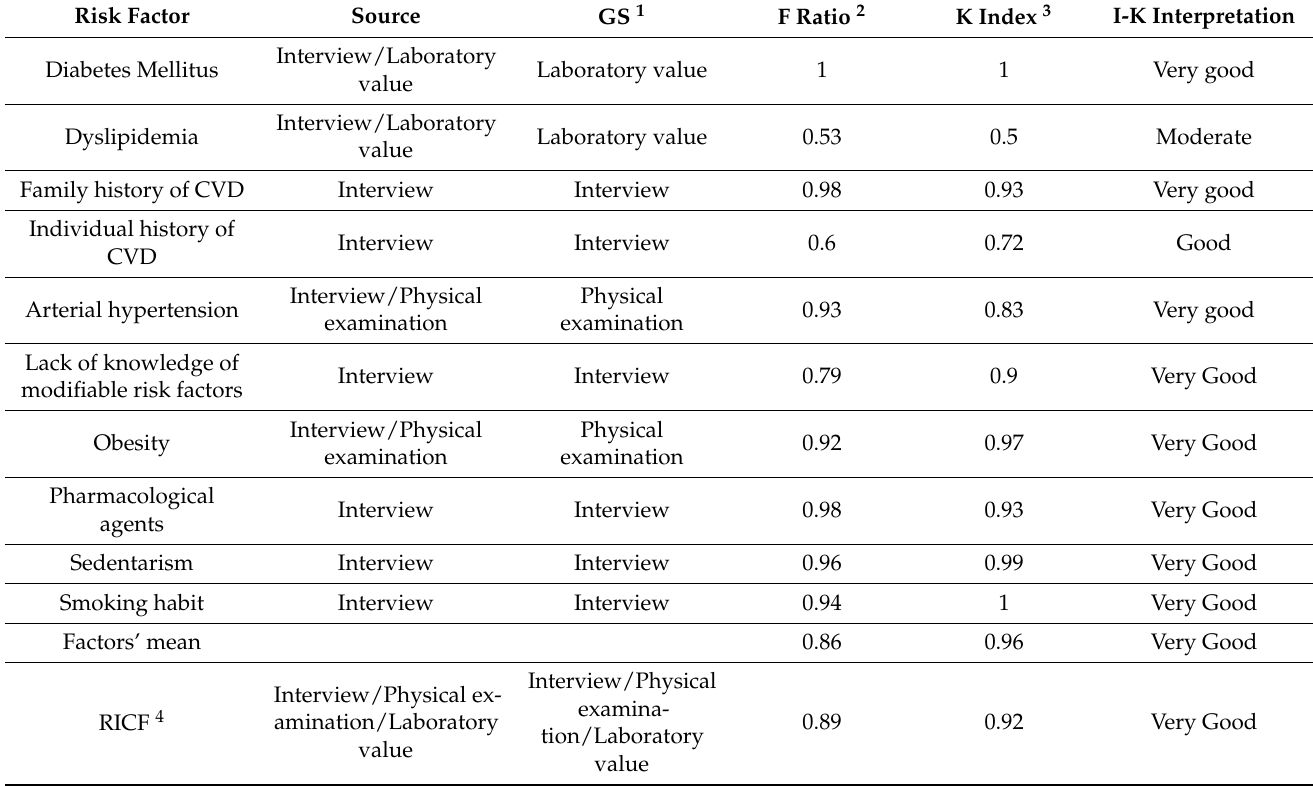
Table 1. Risk of impaired cardiovascular function. Clinical validity results and diagnostic concordance.